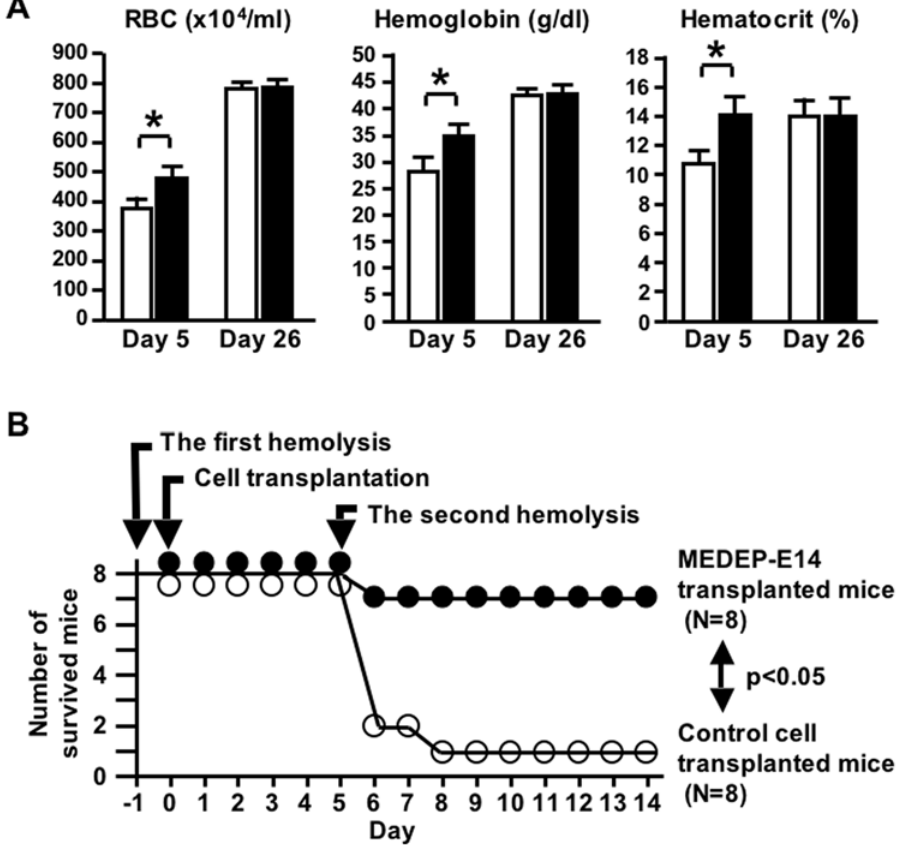
Figure 4. Amelioration of anemia by transplantation of MEDEP. (A) MEDEP-E14 cells (2 6 10 7 cells/mouse) were transplanted into an immuno- deficient mouse (NOD-SCID) 24 hours after the induction of hemolysis by phenylhydrazine (60 mg/kg body weight) injection. Day 5 and Day 26, five and twenty-six days after cell transplantation. RBC, red blood cell. White bars (n=10) and black bars (n=14), the data obtained from the mice transplanted with control cells and MEDEP-E14 cells, respectively. Values are mean 6 S.D. * p , 0.01 (by the Student’s t -test) (B) Increased survival of mice transplanted with MEDEP cells following induction of severe acute anemia. MEDEP-E14 cells (2 6 10 7 cells/mouse) were transplanted into an NOD-SCID mouse 24 hours following the first induction of hemolysis by phenylhydrazine (60 mg/kg body weight) injection. Five days following the cell transplantation, the second induction of hemolysis by phenylhydrazine (80 mg/kg body weight) injection was performed. Statistical analysis was performed using the chi-square test. (A, B) Control cell, mast cell line derived from mouse ES cells (MEDMC-NT2) (Figures S1 and S2). MEDMC-NT2 cells (2 6 10 7 cells/mouse) were transplanted similarly as a control experiment.